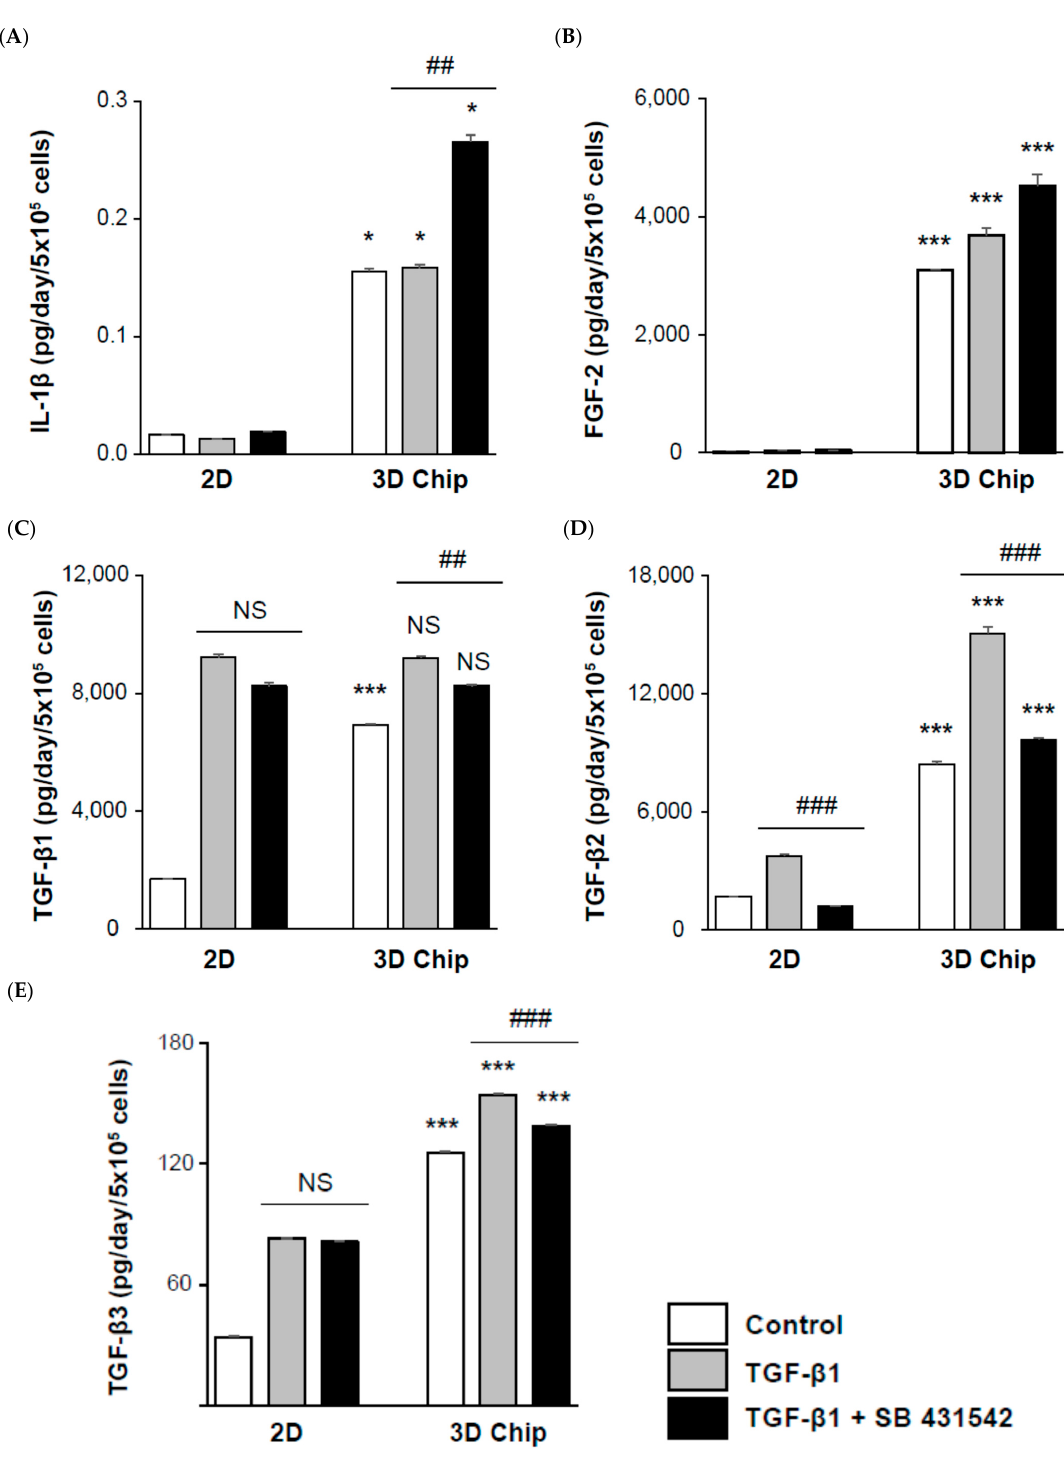
Figure 5. Comparison of 2D- and 3D-cultured models as renal fibrosis-mimicking platforms. Cells were plated at a density of 5 × 10 5 per 2D well or 3D chip and stimulated with 5 ng/mL TGF- β 1 or 10 µm inhibitor (SB 431542) for 24 h. Primary human renal fibroblasts were used in the 2D-cultured and in the 3D-cultured model. Fibroblasts were utilized at a density of 8 × 10 4 cultured with HUVECs and HK-2. The primary human renal fibroblast-to-HUVEC ratio, or F:H ratio, was 1:5 for assessing fibrosis. HK-2 cells were used at a density of 2 × 10 4 . Detection of ( A ) IL-1 β , ( B ) basic fibroblast growth factor (FGF-2), and ( C – E ) TGF-beta 1, 2, and 3 in the supernatant was performed by multiplex analysis of cytokines and multiplex bead immunoassay. Each bar represents the mean ± SE. * p < 0.05, *** p < 0.001 versus 2D; ## p < 0.01, ### p < 0.001 versus TGF- β 1.